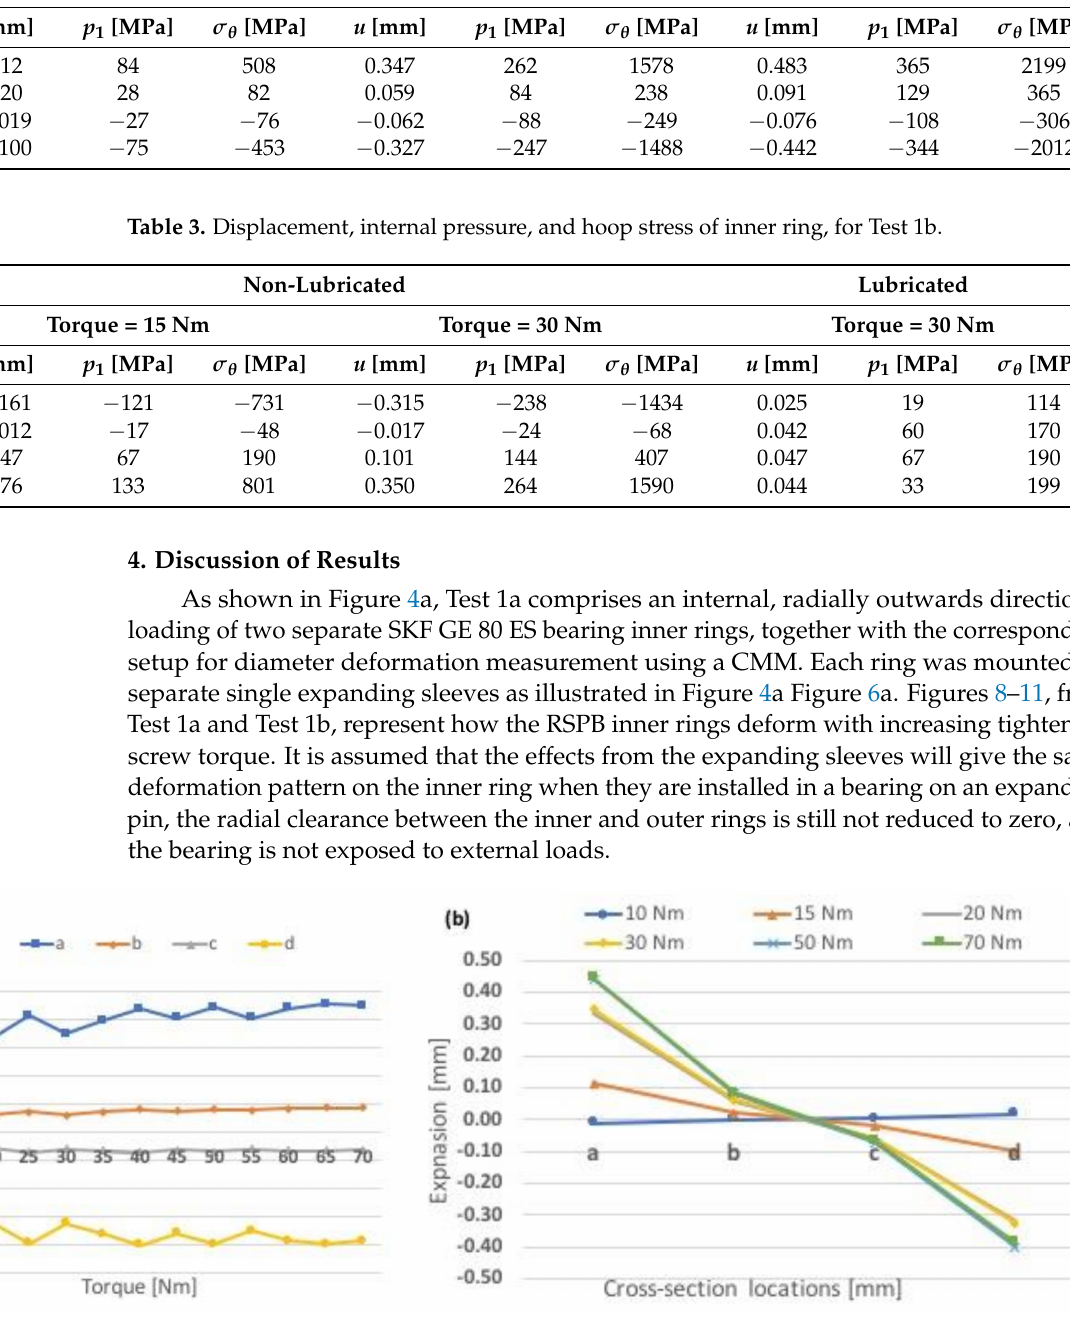
Figure 8. Test 1a—Ring deformations of non-lubricated bearing ring on single sleeve: ( a ) expansion as a function of torque and ( b ) expansion at different cross-section